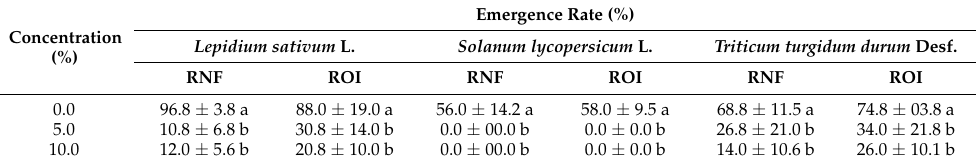
Table 6. Emergence rate of cress, tomato and durum wheat in response to different concentration of retentates (1).